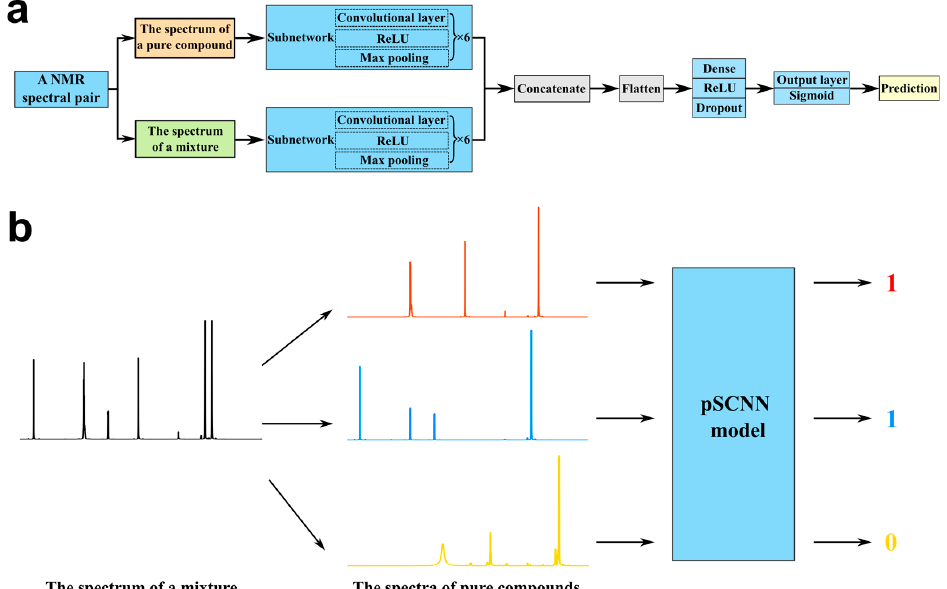
Figure 1. Schematic diagram of the proposed pSCNN method. ( a ) The network architecture of the pSCNN model. pSCNN consists of two subnetworks. Each subnetwork consists of six convolutional layers. The extracted features are concatenated and fed into two dense layers for prediction. ( b ) pSCNN model-based component identification. The inclusion relationship between each compound in the database and a mixture is predicted by the pSCNN model.